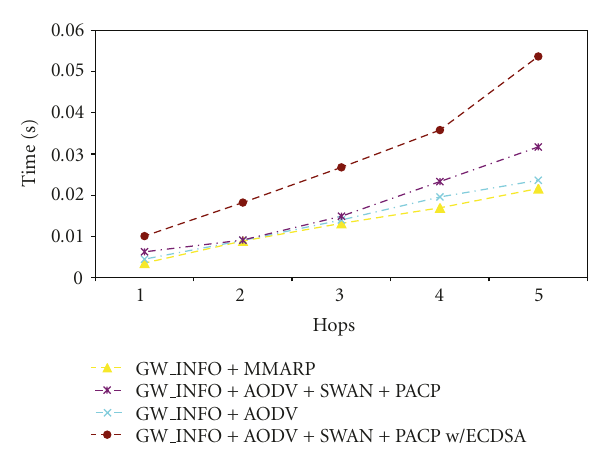
Figure 10: Cumulative delay for the 64 kbits tra ffi c profile.